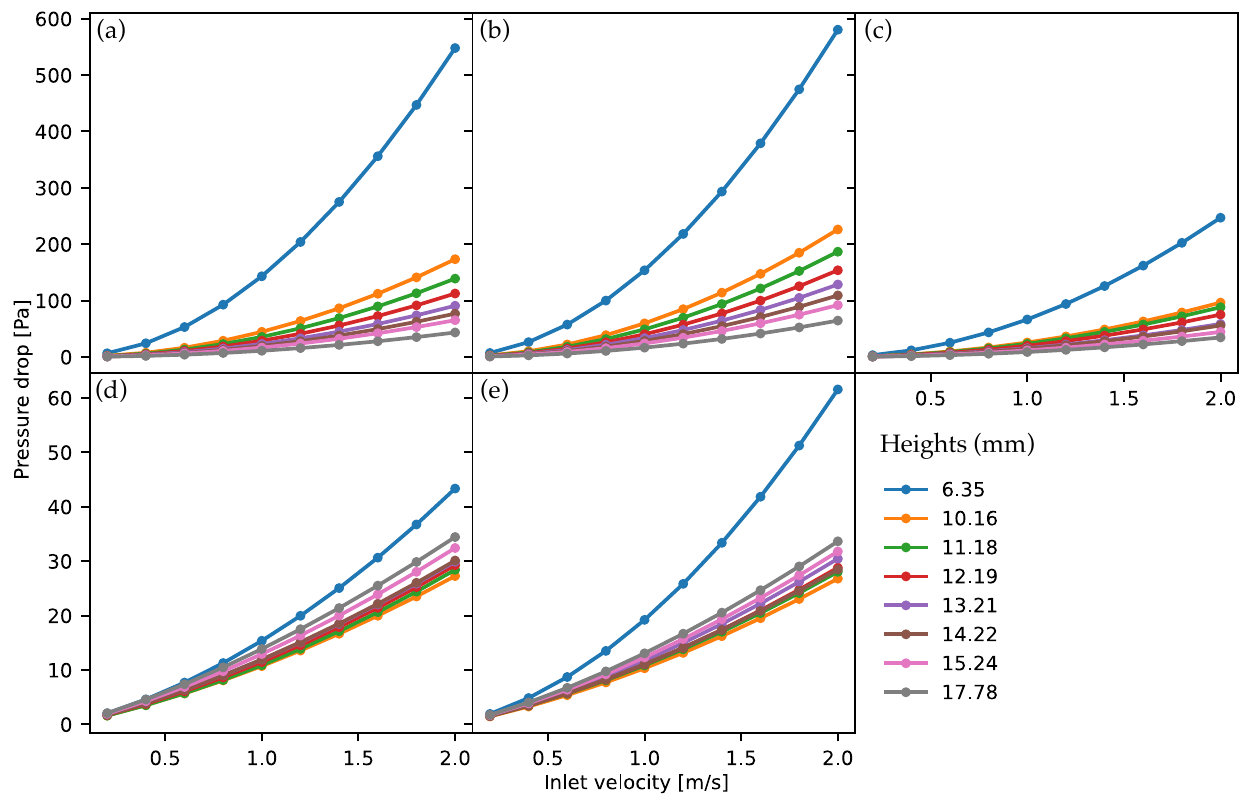
Figure 7. Pressure drops across PCM–air heat exchanger panels. Total pressure drop for varying pouch heights and inlet velocities for ( a ) PY, ( b ) PYO, ( c ) PYR, ( d ) CY, and ( e ) CYO